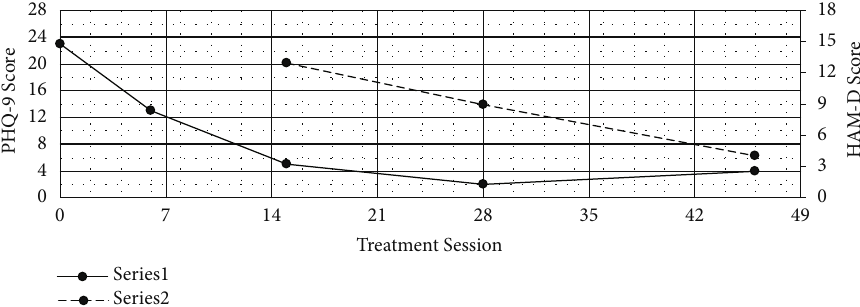
Figure 1: Patient reported outcomes for depression after Esketamine treatment. Over the course of treatment, the patient reported decreases in PHQ-9 and HAM-D scores. Series 1 indicates the PHQ-9 and series 2 indicates the HAM-D. Both demonstrate signi fi cant decreases in disease